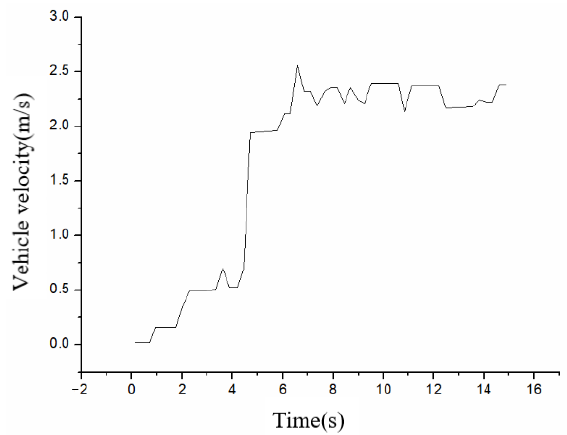
Figure 10. Vehicle velocity with SMC.